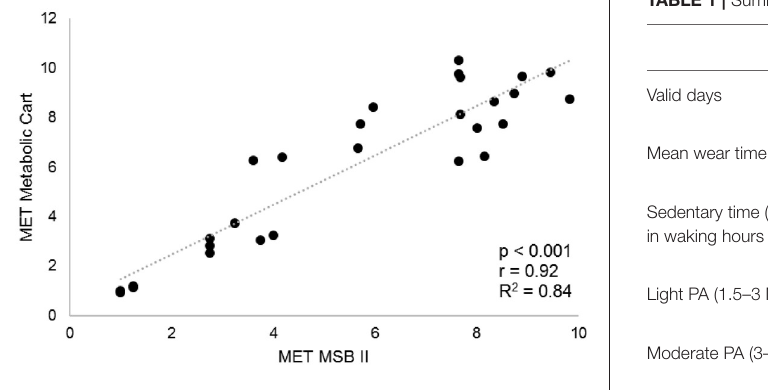
FIGURE 1 | Correlation analysis of energy expenditure measured by MSBII and indirect calorimetry (Cortex Metamax 3B) of nine subjects sitting, standing, walking and jogging.